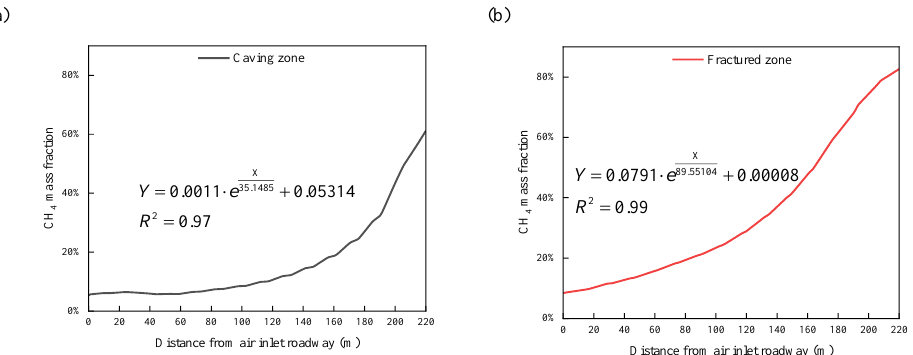
Figure 6. Variation curve of gas mass fraction in the inclination direction ( a ) caving zone ( b ) fracture zone.